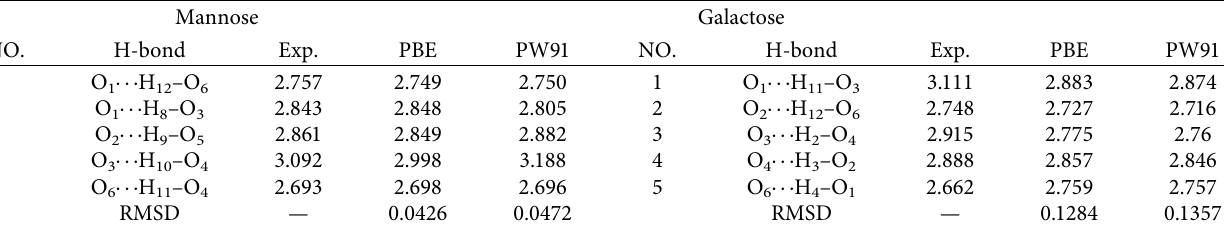
Table 3: Calculated hydrogen-bond lengths (˚A) and RMSD values of mannose and galactose compared to experimental X-ray values a . Mannose Galactose NO.